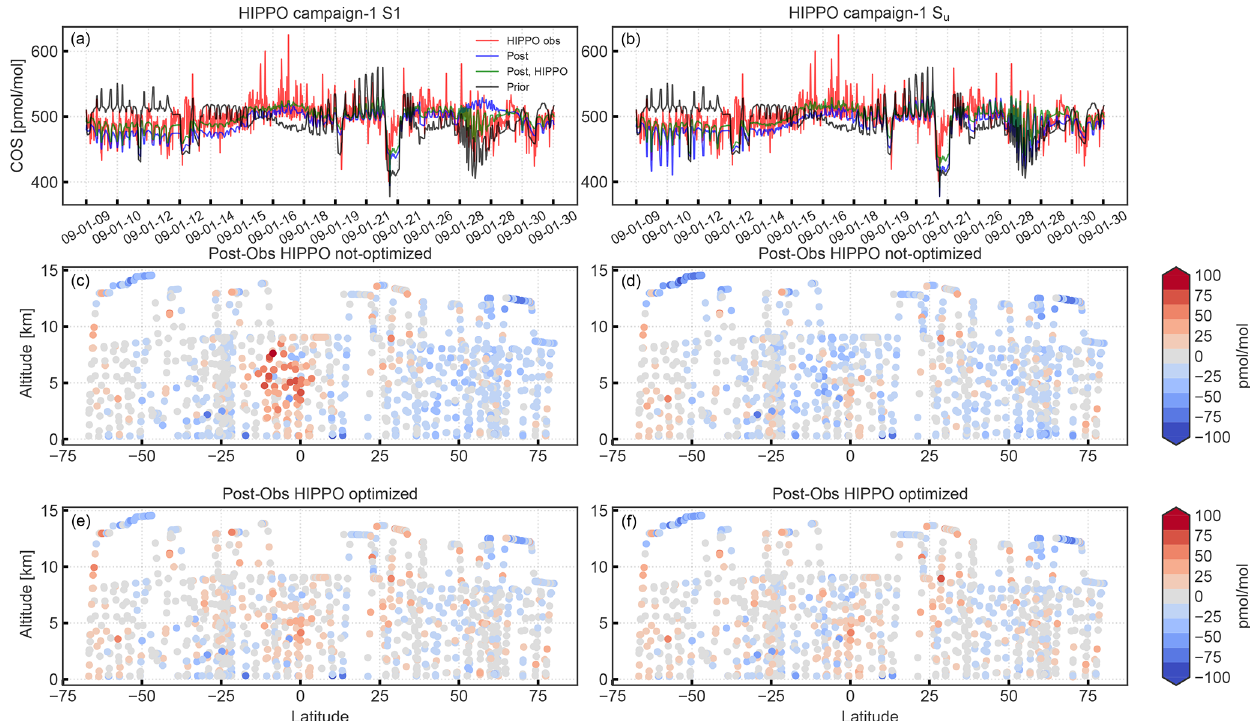
Figure 8. HIPPO campaign-1 COS observations compared to results from inversions S1 (a, c, e) and S u (b, d, f) . The first row shows time series of HIPPO observations (red), prior (black), posterior (blue), and posterior with HIPPO observations assimilated (green). The middle and bottom rows show the model minus observations in a latitude–height plot for inversions with and without assimilating HIPPO observations,